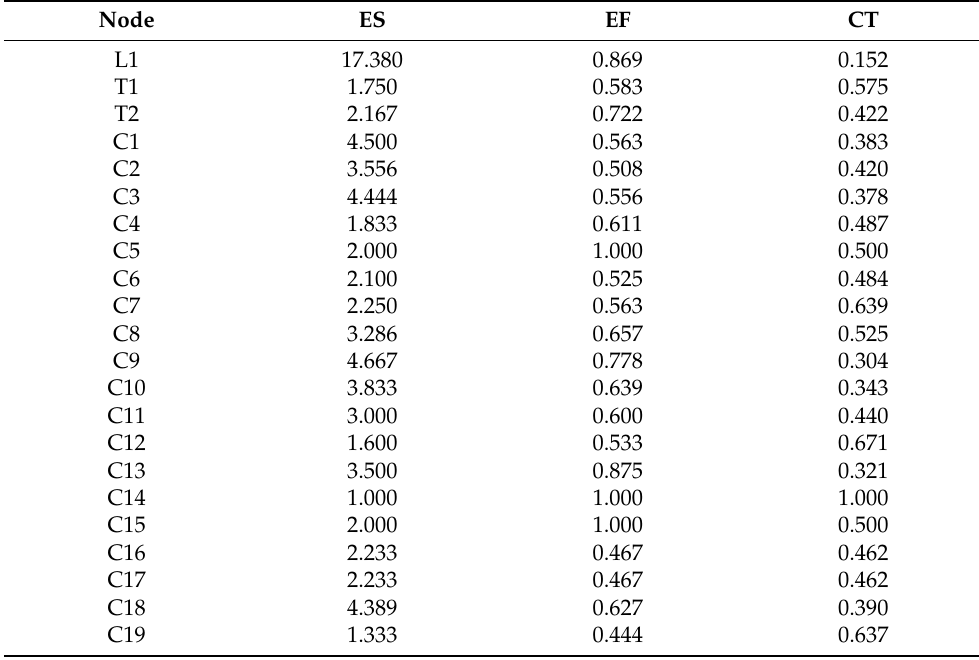
Table 8. The index values of structural